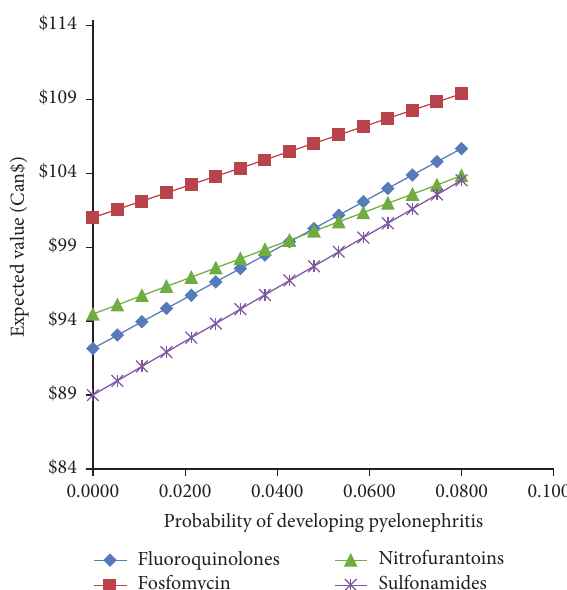
Figure 6: Comparison of the expected value of the cost-per- patient when treating uUTI with fluoroquinolones, sulfonamides, nitrofurantoin, and fosfomycin versus the probability of developing pyelonephritis.